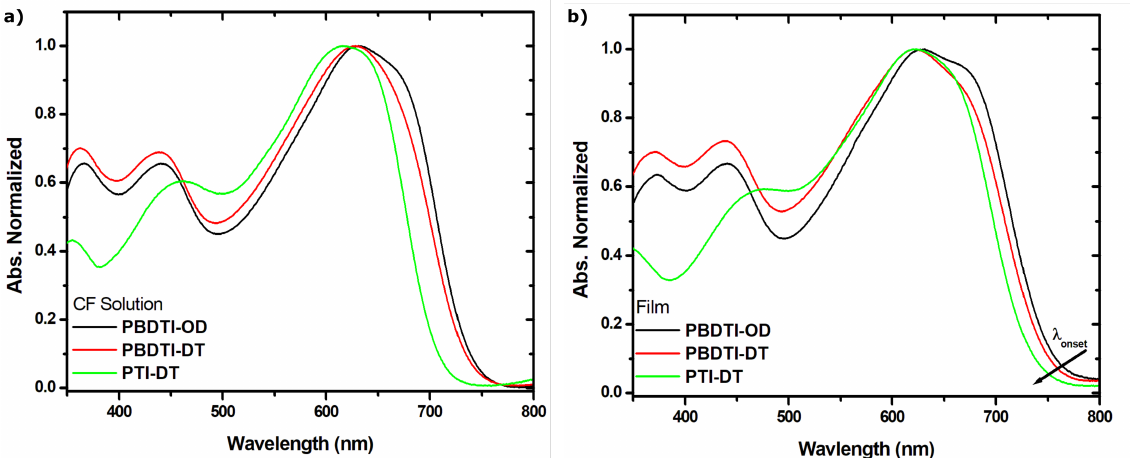
Figure 1. Absorption spectra of PBDTI-OD (black), PBDTI-DT (red) and PTI-DT (green) in ( a ) CF solutions and ( b ) thin films.